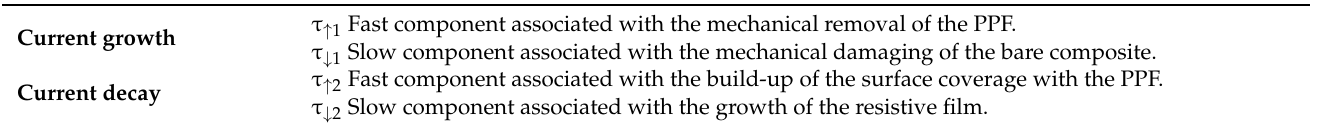
Table 3. The time constants of the bi-exponential function employed to fit current growth and decay during transients.